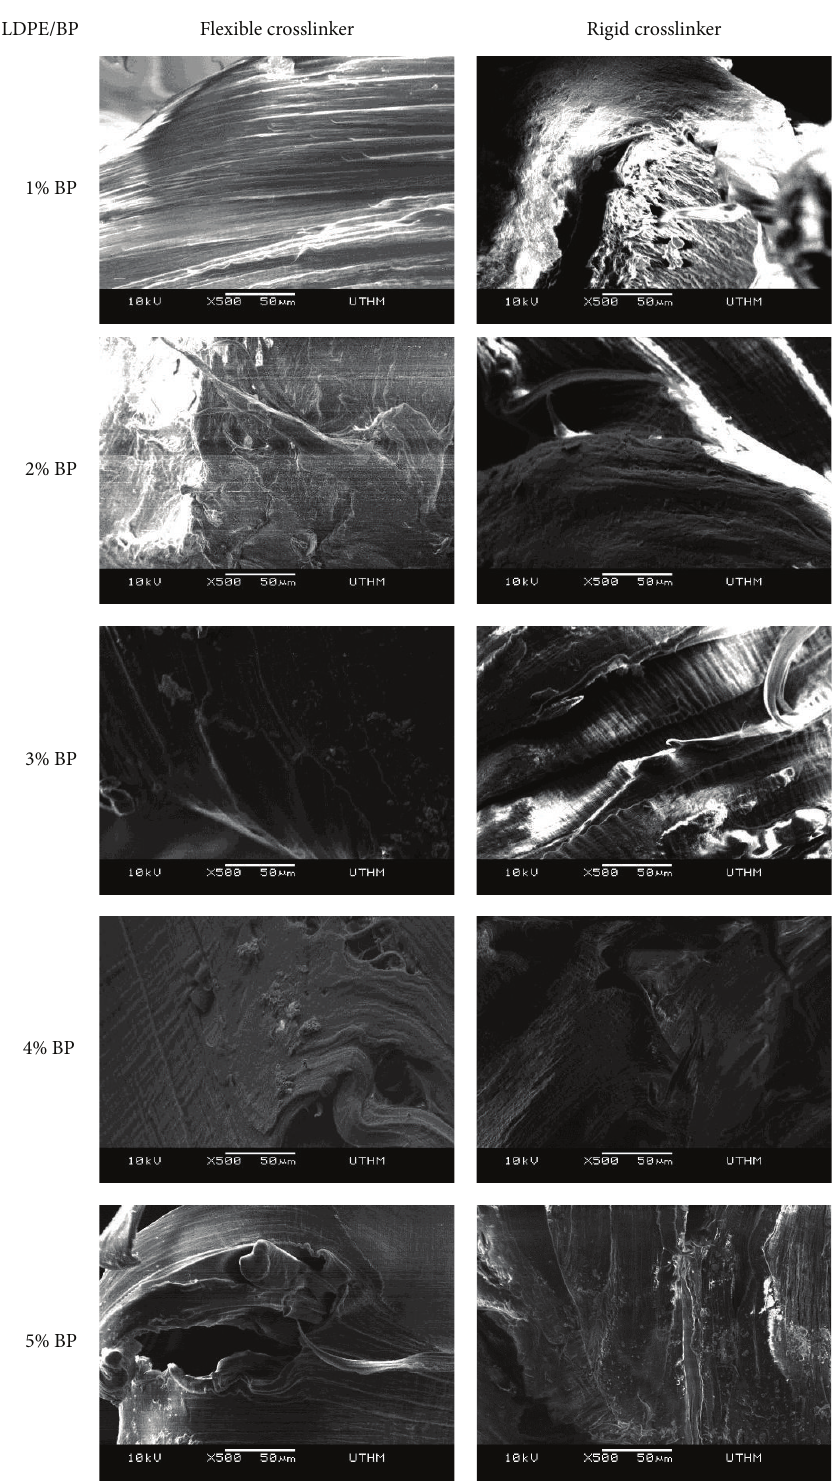
Figure 7: SEM images for all LDPE/BP specimens at 500x